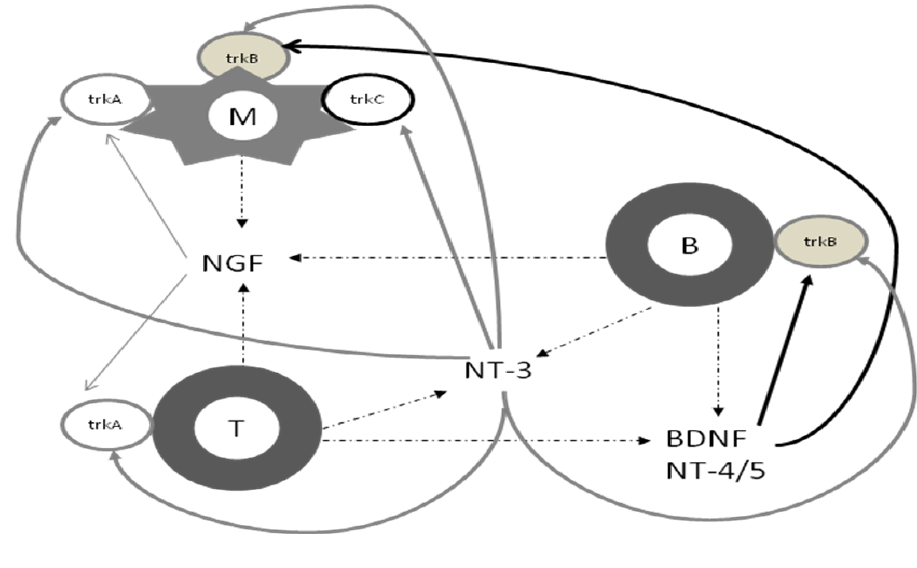
Figure 2. Interactions between neurotrophins and the immune cells. NGF: nerve growth factor, BDNF: brain-derived neurotrophic factor, NT-3: neurotrophin 3, NT-4/5: neurotrophin 4/5, trk: tropomyosin related kinase receptor, M: macrophage, T: T lymphocyte, B: B lymphocyte. Dotted lines indicate secretion. Straight lines indicate affinity towards